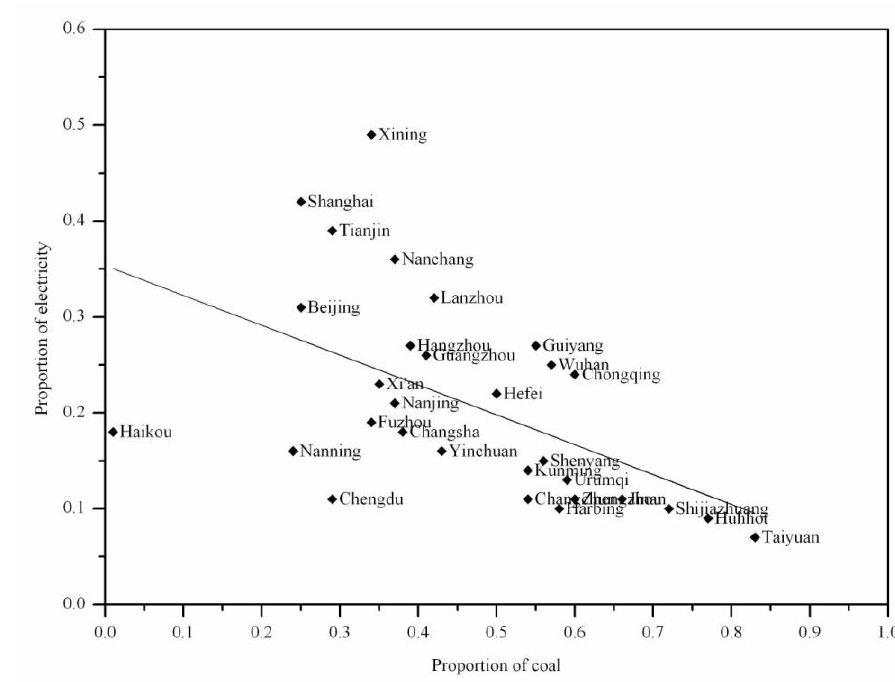
Figure 6. The relation between the percentage of coal in energy consumption and that of electricity in China provincial capital cities in